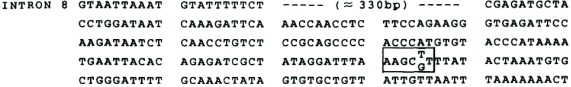
Intron 8, restriction site of
HindIII (AAGC TT > AAGC GT).The authors confirm that this is an original image and has not been re-used or adapted from another source.